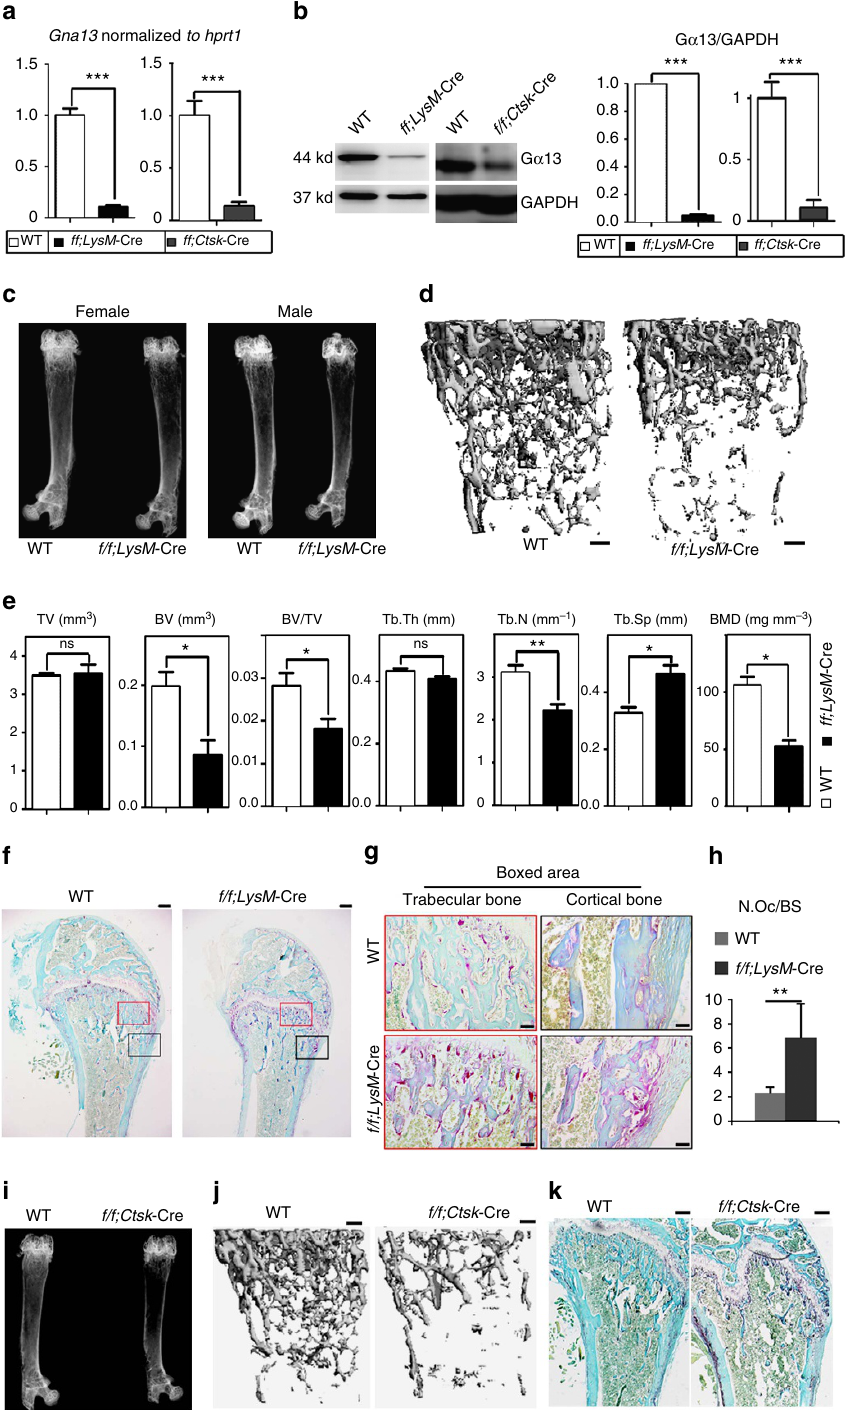
Figure 2 | Osteoclast-specific Gna13 -CKO mice displayed osteoporosis. ( a ) Quantitative reverse transcription–PCR confirmed deletion of Gna13 mRNA in day-1 Gna13 f/f LysM -Cre ( f/f;LysM- Cre) and day-4 Gna13 f/f Ctsk -Cre ( f/f;Ctsk- Cre) pre-osteoclasts; N ¼ 6. ( b ) Western blot confirmed deletion of G a 13 protein in Gna13 f/f LysM -Cre BMMs and day-5 Gna13 f/f Ctsk -Cre pre-osteoclasts. Quantification is co-presented in the right panels; N ¼ 6. ( c ) Radiographs of two-month-old wild type (WT) and Gna13 f/f LysM -Cre male and female mice femurs. ( d ) m -CTanalysis of two-month-old WTand Gna13 f/f LysM -Cre female mice femurs. ( e ) Quantification from d ; N ¼ 6. BMD, bone mineral density; BV, bone volume; Tb.Th, trabecular bone thickness; Tb.N, trabecular bone number; Tb.Sp, trabecular bone space; TV, tissue volume. ( f ) TRAP staining of 2-month-old WT and Gna13 f/f LysM -Cre female mice femurs. ( g ) High magnification images of f . ( h ) Quantification of N.Oc/BS (osteoclast number / bone surface) in f ; N ¼ 6. ( i ) Radiographs of two-month-old WT and Gna13 f/f Ctsk -Cre female mice femurs. ( j ) m -CTanalysis of two-month-old WTand Gna13 f/f Ctsk -Cre female mice femurs. ( k ) TRAP staining of 2-month-old WTand Gna13 f/f Ctsk -Cre female mice femurs. WT, wild-type. Results were expressed as mean ± s.d.; * P r 0.05; ** P r 0.01; *** P r 0.001; ns, not significant (Student’s t -test). Scale bars in d , f , j , k , 200 m m; Scale bar in g , 20 m